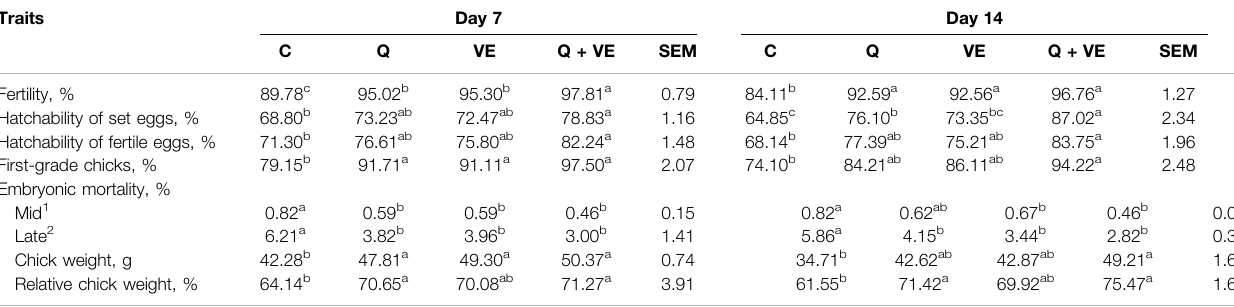
TABLE 5 | Impacts of Q, VE, and Q + VE on fertility, embryonic mortality and hatchability. Traits Day 7 Day 14